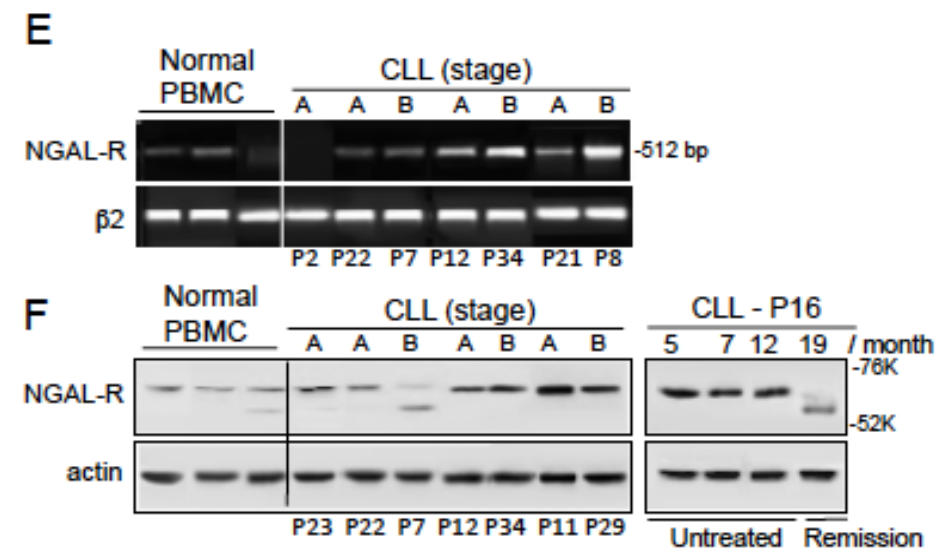
Figure 3. Expression profiles of NGAL receptor (NGAL-R) in PBMCs from healthy individuals, and CLL cells from patients before and after therapeutic treatment. ( A ) Representative cytograms of normal PBMCs stained with rabbit IgG-FITC / mIgG1-PE, NGAL-R-FITC / CD14-PE, NGAL-R-FITC / CD3-PE, NGAL-R-FITC / CD19-PE Abs. ( B ) Representative cytogram of CLL cells from one untreated patient, stained with rabbit IgG-FITC / mIgG1-PE, NGAL-R-FITC / CD19-PE and NGAL-R-FITC / CD5-PE Abs. ( C ) NGAL-R surface levels were determined, (with rabbit IgG-FITC and NGAL-R-FITC) in PBMCs and purified CD19 + B cells from healthy individuals, and CLL cells from patients before treatment or at remission or relapse. The data are presented as mean ± SEM (normal PBMCs, n = 7 healthy donors; isolated B cells, n = 6 healthy donors; CLL cells, n = 47 untreated patients, n = 8 patients in remission and n = 7 relapsed patients). p values were calculated using a Mann–Whitney U -test; not significant (ns); * p < 0.05; *** p < 0.001. ( D ) Expression of surface NGAL-R in CLL cells